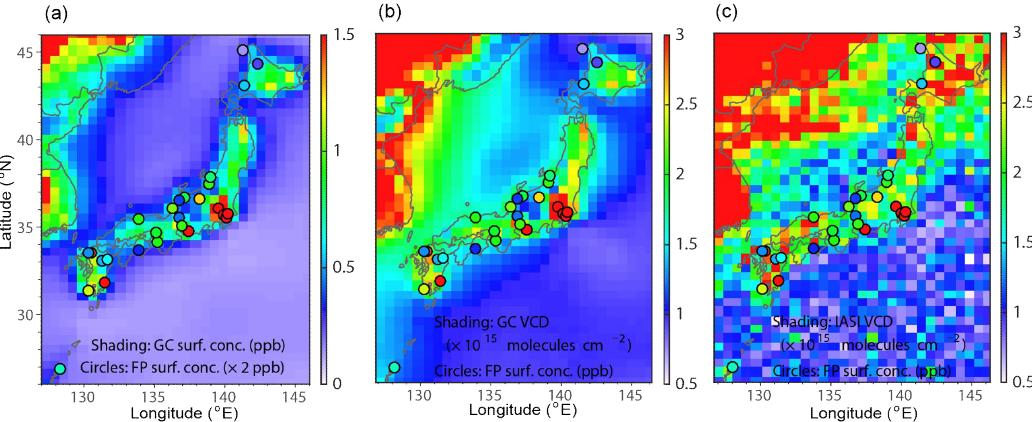
Figure 5. Horizontal distribution of the annual averaged FP surface NH 3 concentrations over Japan (colored circles) and comparison with ( a ) GEOS-Chem surface concentration, ( b ) GEOS-Chem NH 3 VCD, and ( c ) IASI NH 3 VCD shown as shadings.